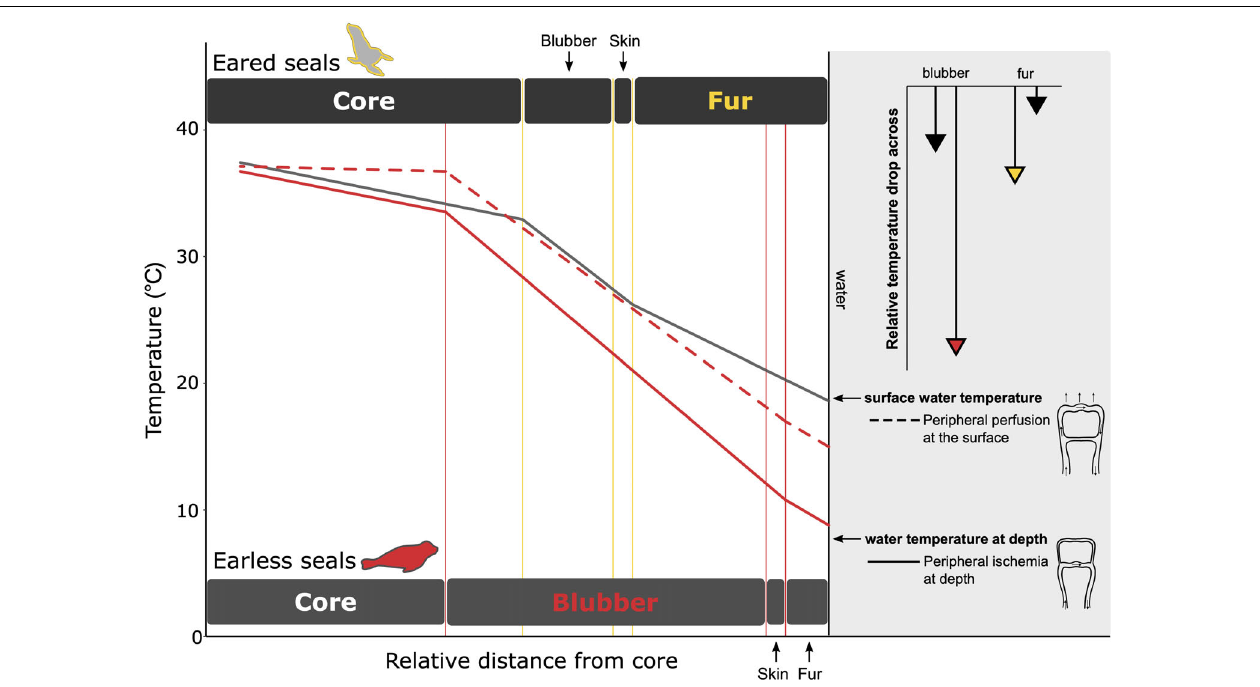
FIGURE 8 | A comparison of the temperature gradients within the fur and blubber layer for eared (gray line) and earless seals (red line) that primarily depend on fur and blubber, respectively, for insulation. The relative thicknesses of the insulation layers are scaled based on the thickness of the primary insulation needed to provide equal insulation for each species. While diving (solid lines), peripheral vasoconstriction reduces blood flow to the periphery. For earless seals, this mitigates heat loss by keeping the skin within a few degrees of water temperature. For eared seals, the air layer in the fur provides an insulative barrier and prevents such a drastic reduction in peripheral temperature. The lengths of the arrows in the upper right depict the extent to which temperature decreases in the primary (colored arrowhead) vs. secondary (black arrowhead) insulation layer when at depth. Larger temperature drops are observed in the primary insulative layer—fur for the eared seal and blubber for the earless seal–due to its lower conductivity when compared to that of the other species: pelt conductivity of the eared seal (0.11 W m − 1 ◦ C − 1 ) < earless seal (0.16 W m − 1 ◦ C − 1 ) whereas blubber conductivity of the earless seal (0.19 W m − 1 ◦ C − 1 ) < eared seal (0.28 W m − 1 ◦ C − 1 ). At the surface, peripheral perfusion reduces the temperature gradient within the core and blubber layer (dashed line), resulting in warmer skin temperatures. Data sources: Northern fur seal, Callorhinus ursinus (Scheffer, 1961; Ohata et al., 1977; Liwanag, 2008; Sharma and Liwanag, 2017); Northern elephant seal, Mirounga angustirostris (Kuhn and Costa, 2006; Favilla, unpublished